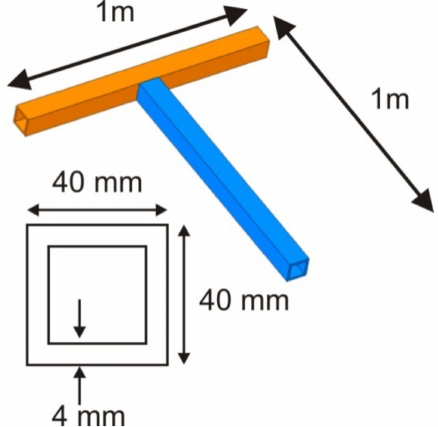
Figure 2. Analyzed T-junction with the cross section